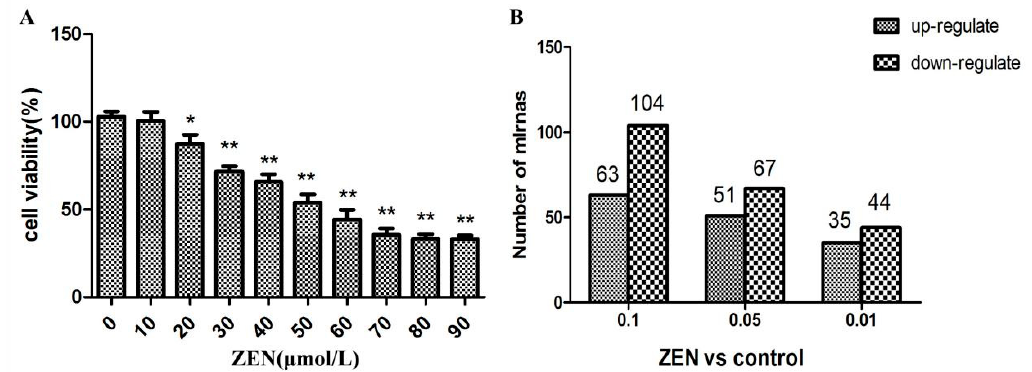
Figure 1. ( A ) Effect of zearalenone (ZEN) on the proliferation of TM3 Leydig cells. Cytotoxic effects of ZEN on TM3 Leydig cells. Cells were treated with increasing concentrations (0–90 µ mol/L) of ZEN for 24 h and then processed for the CCK-8 assay. Data are expressed as the mean ± S.E.M. of three independent experiments. * p < 0.05; ** p < 0.01. ( B ) Differential expression of miRNA in the ZEN exposure groups.